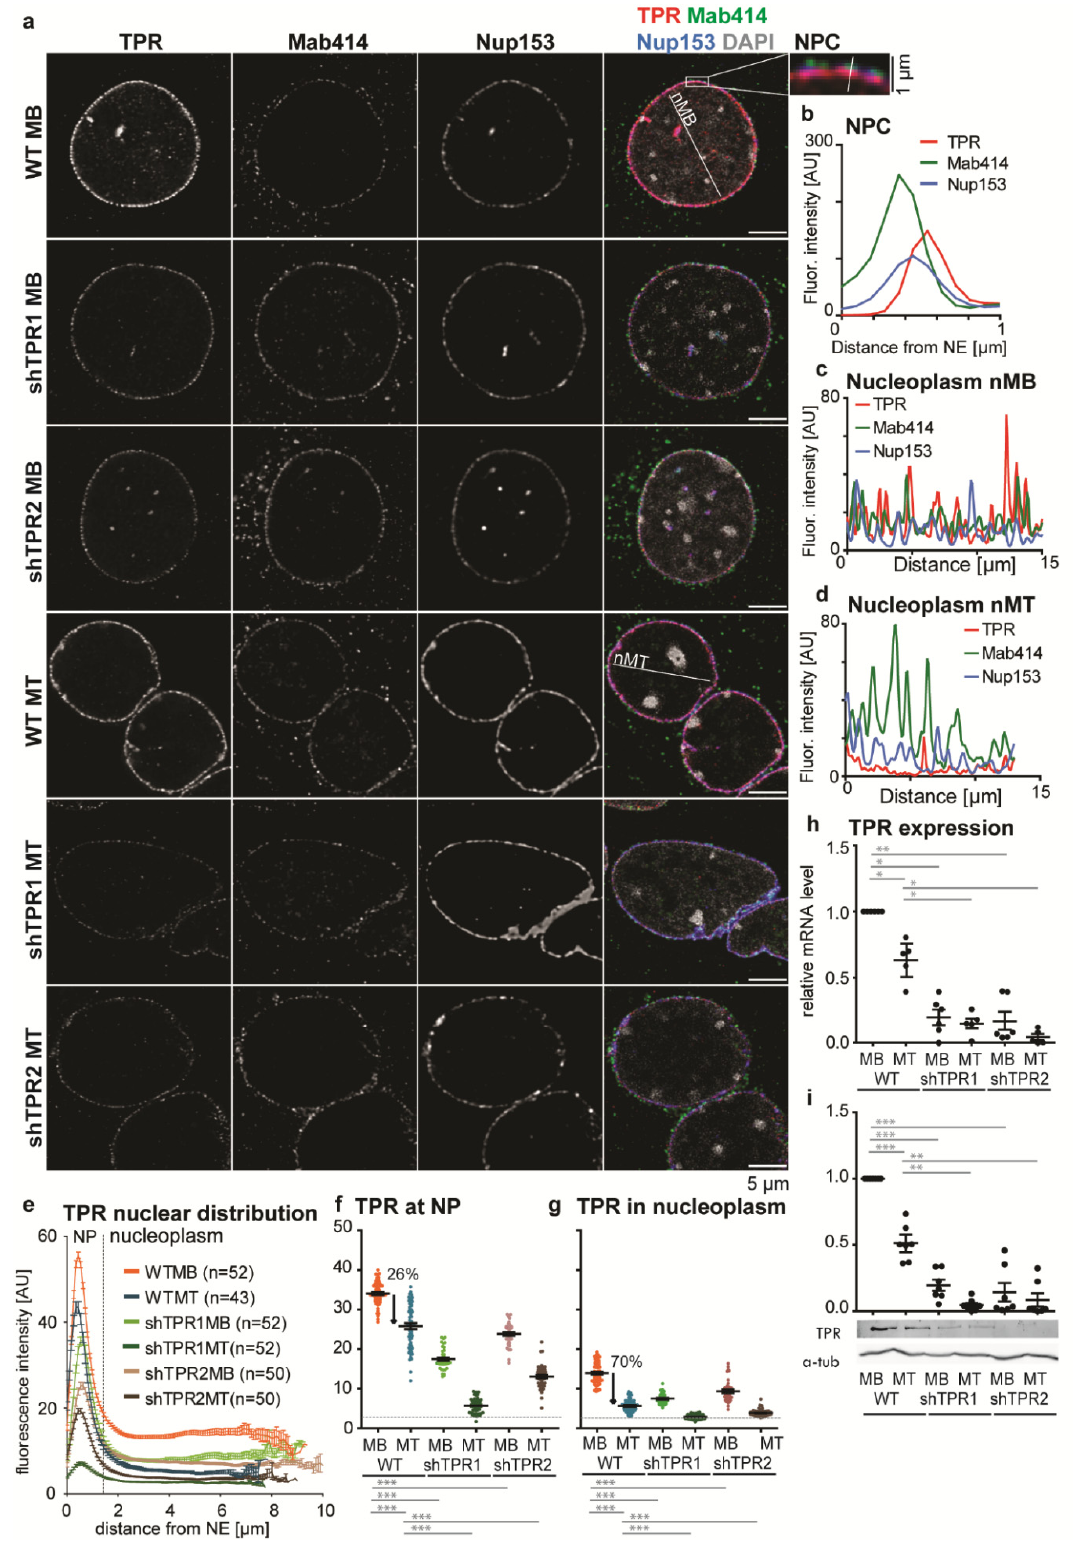
Figure 1. TPR localization and expression in the C2C12 cell line. ( a ) Nuclei of WT and TPR-depleted (shTPR1, shTPR2) C2C12 MBs and MTs (differentiated for 4 days) immunostained with anti-TPR-C (red, labeled with Alexa Fluor 555), Mab414 (staining central NUPs—green, labeled with Alexa Fluor 488) and NUP153 (blue, labeled with Alexa Fluor 647). Zoom-in shows spatial distribution of TPR, NUP153 and Mab414 within the NPC. ( b ) Plot profile depicts distribution of TPR,